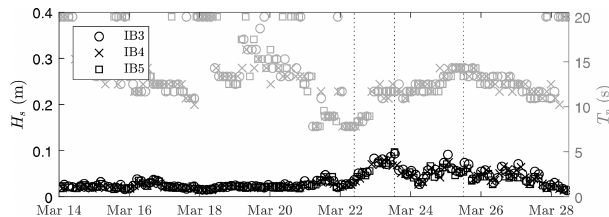
Figure 7. Significant wave height and peak period measured by three ice buoys deployed on fast ice in Svalbard. The dashed lines identify three events with distinct peak wave period and peak sig- nificant wave